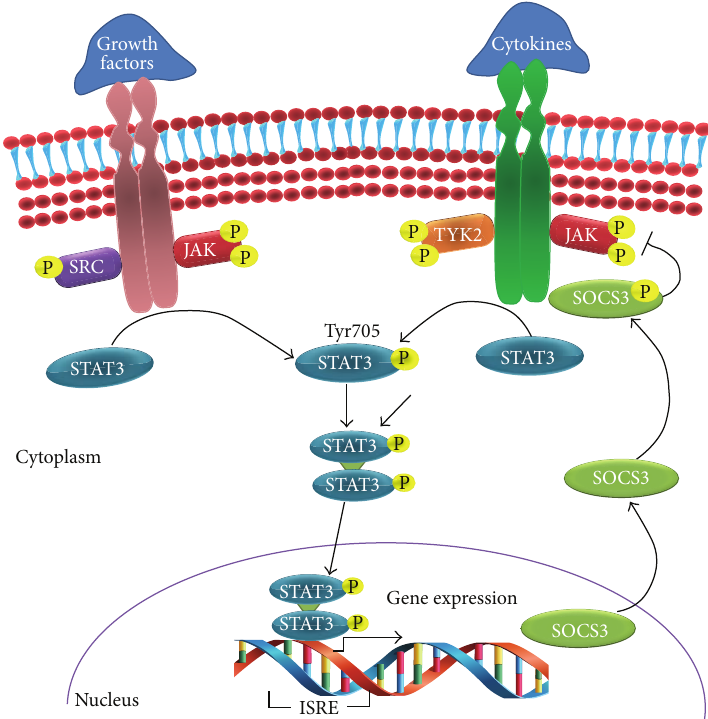
Figure 2: STAT3 signal transduction pathway. In response to cytokines and growth factors, STAT3 is phosphorylated by receptor-associated kinases and then forms homo- or heterodimers. STAT3 dimers then translocate to the nucleus where they act as a transcription activator and mediate the expression of a variety of genes. STAT3 activates the transcription of suppressors of cytokine signalling 3 (SOCS3) which act as classical feedback inhibitor of STAT3